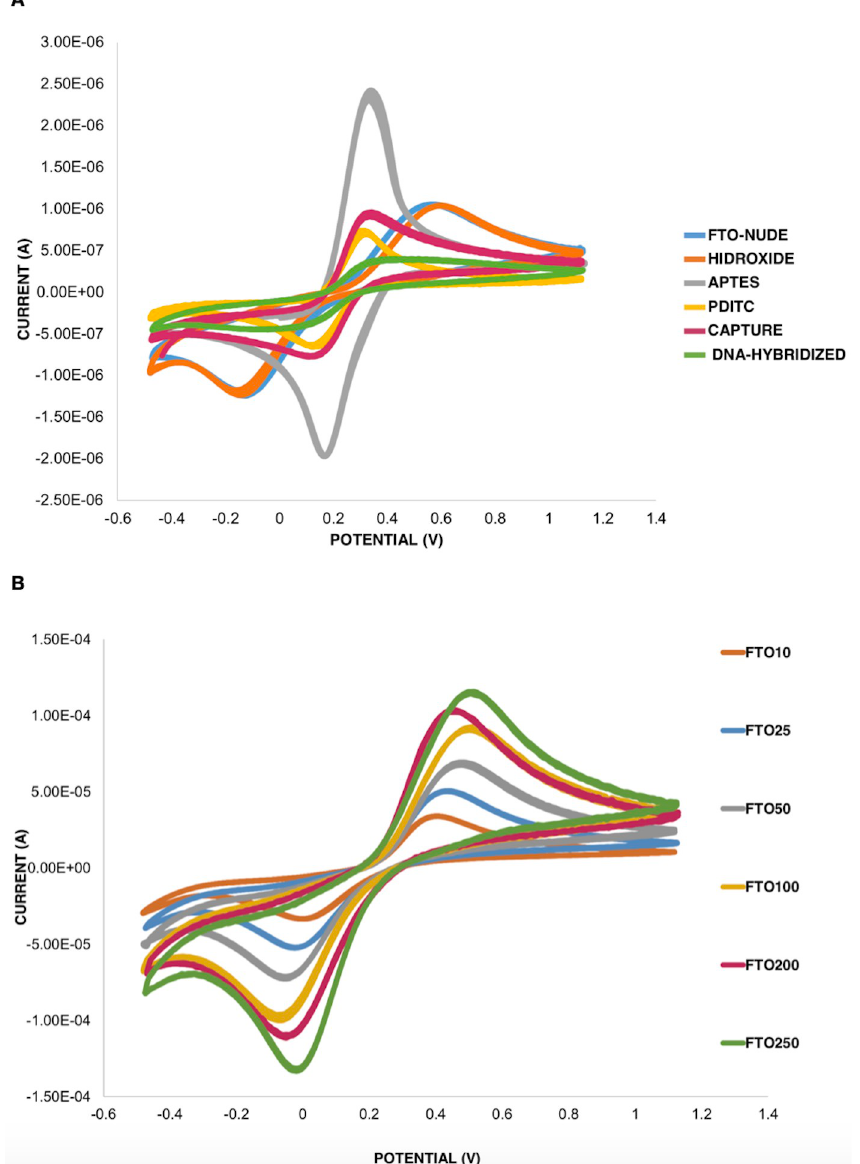
Fig 3. (A) Voltagrams of each stage of immobilization in an electrochemical cell with a three-electrode configuration; Reference electrode (Ag / AgCl 1.0 M), Counter-electrode (Platinum), Working electrode (FTO-MODIFIED) Ferri / Ferro 0.1 M in Buffer PBS 0.1 M, in a potential window -0.400 to 1.100 V, at a rate of 100 mV/s. (B) Voltagrams of the different scanning rates using the FTO-DNA capture electrode, ranging from 10 mV/s to 250 mV/s.